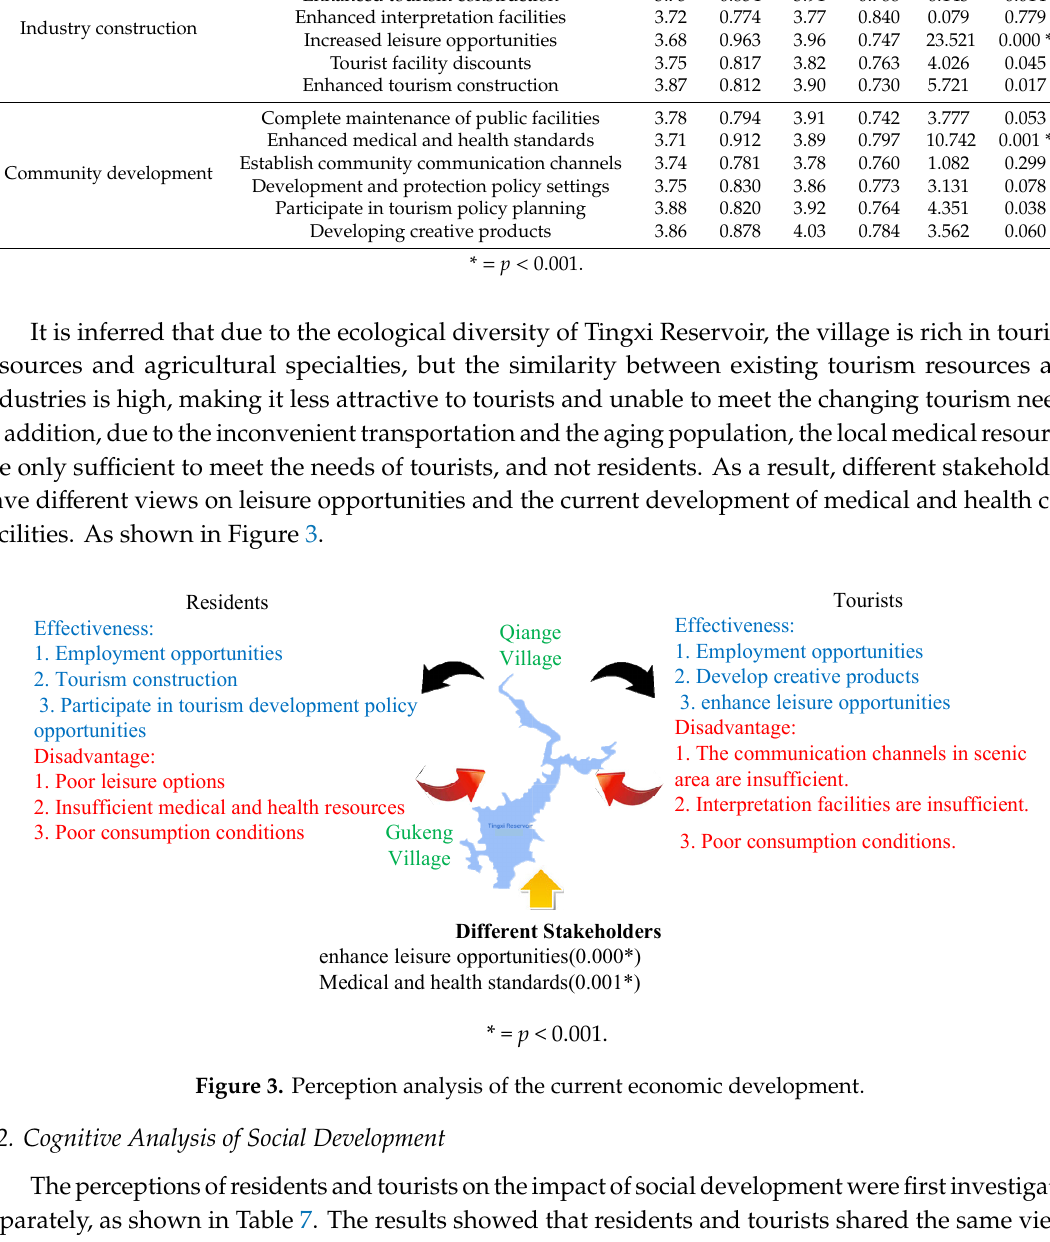
Table 7. The perceptions of the residents and tourists of the current social development.